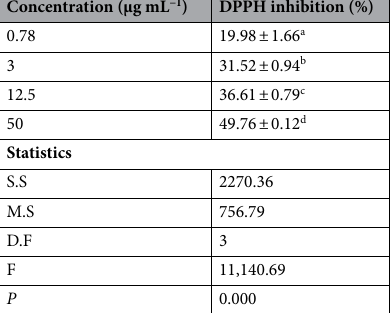
Table 1. Antioxidant activity of a mixture of spinasterol and 22,23-dihydrospinasterol. Values are means of five replicates ± standard error. Different letters indicate significantly different values at the P = 0.05 level (Duncan’s multiple range test, DMRT).